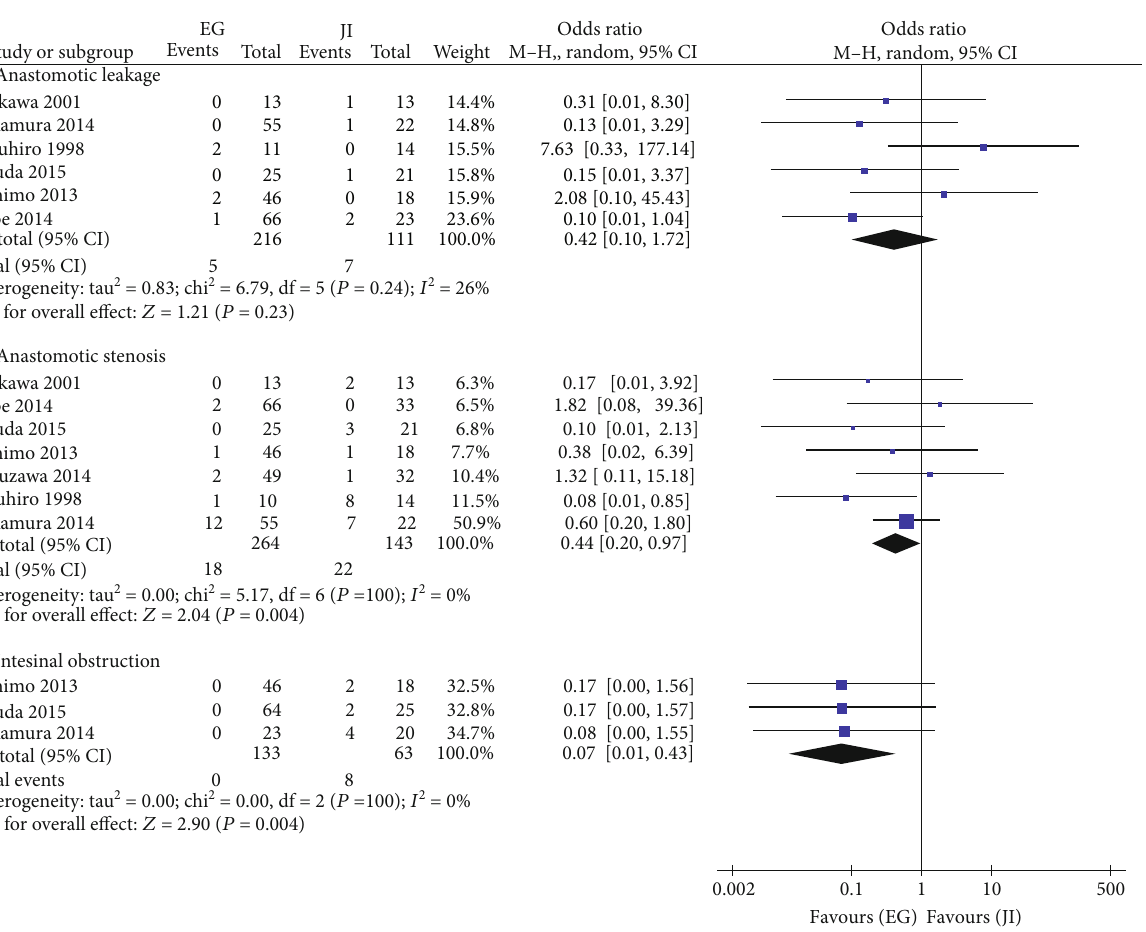
Figure 3: Meta-analysis of postoperative complications associated with EG versus JI: (a) anastomotic leakage, (b) anastomotic stenosis, and (c) intestinal